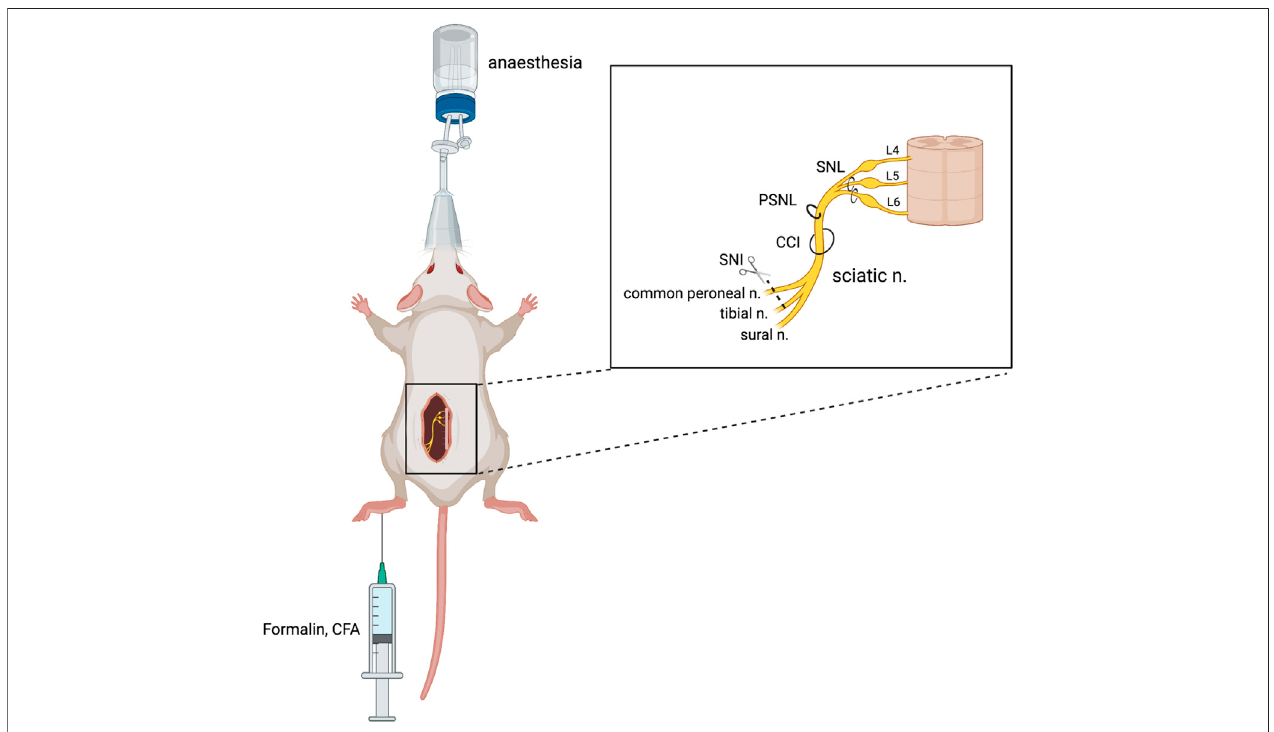
FIGURE2| Animal models ofchronic neuropathicpain. Neuropathic pain canbe produced surgically via damageto aperipheral nerve,eitherthrough spinal nerve ligation (SNL), partial sciatic nerve ligation (PSNL), sciatic chronic constriction injury (CCI), or spared nerve injury (SNI). Chemical injection into the plantar surface of the hind paw can produce in fl ammatory (CFA) and neuropathic (formalin) pain models. Figure adapted from Bravo et al. (2020) and created with